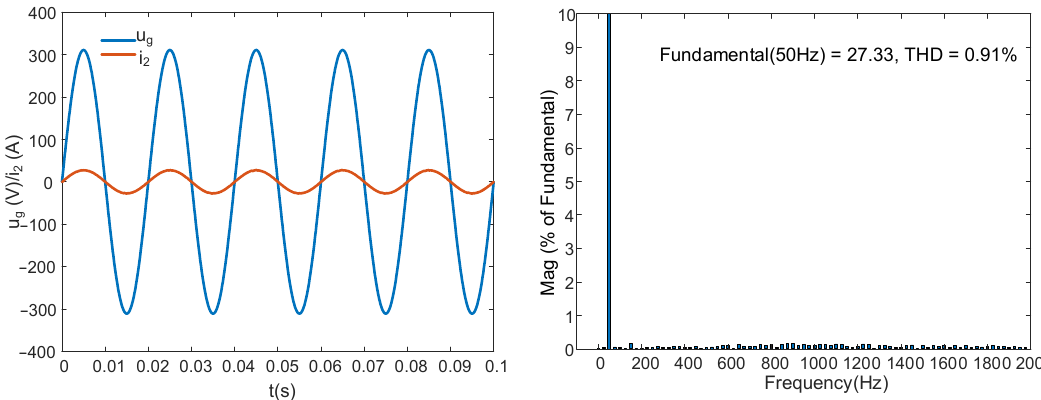
Figure 16. Simulation results of the “FOGCI + IOPI” system with α + β ≠ 2.